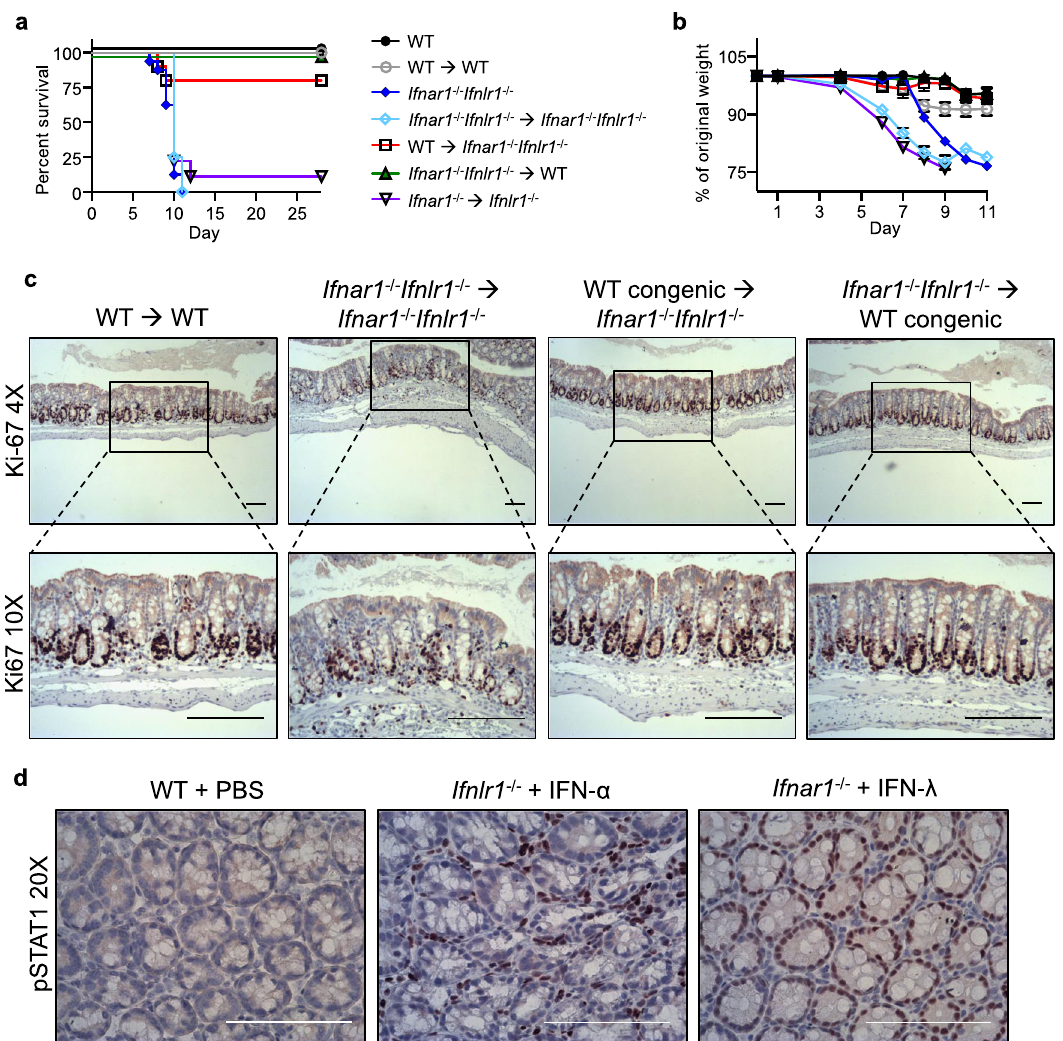
Fig. 5 Compartmentalized IFN signaling supports epithelial proliferation in experimental DSS-induced colitis. a – c Indicated bone marrow chimera mice and age-matched WT and Ifnar1 − / − Ifnlr1 − / − mice were exposed to 1.5 % DSS in drinking water for 7 days, followed by regular water for recovery. Mice were monitored daily for a survival and b weight loss (WT, n = 8; WT → WT, n = 5; Ifnar1 − / − Ifnlr1 − / − , n = 14; Ifnar1 − / − Ifnlr1 − / − → Ifnar1 − / − Ifnlr1 − / − , n = 4, Ifnar1 − / − Ifnlr1 − / − → WT, n = 10; WT → Ifnar1 − / − Ifnlr1 − / − , n = 10; Ifnar1 − / − → Ifnlr1 − / − , n = 9). Data are presented as mean values with SEM. c Mice were euthanized on day 8 and colon epithelial cell proliferation was evaluated by IHC staining for Ki-67 ( n = 5). d 6 – 8-week-old WT mice were treated with IFN (1.0 μ g) or PBS as a control by subcutaneous injection, and euthanized 30 min later. IFN-induced activation of STAT1 was evaluated by IHC staining with antibodies against phosphorylated STAT1 ( n = 5). Scale bars are 100 μ M. Data are representative of two independent experiments ( a – d